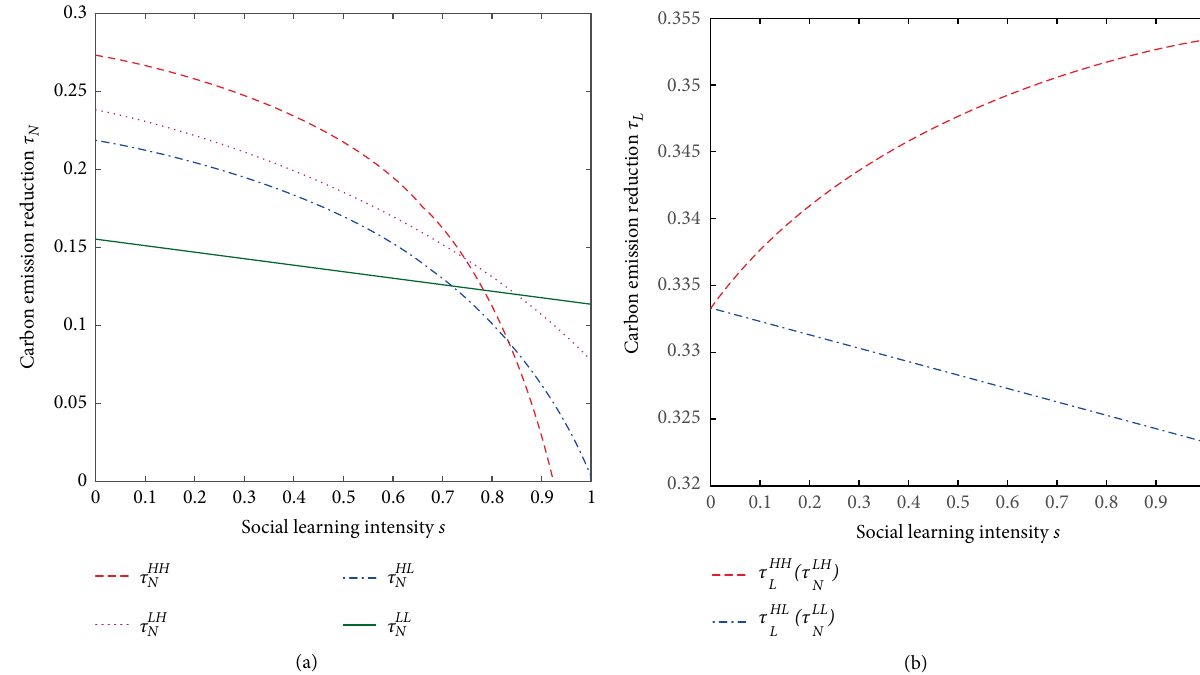
Figure 1: (a) Relationship between 𝜏